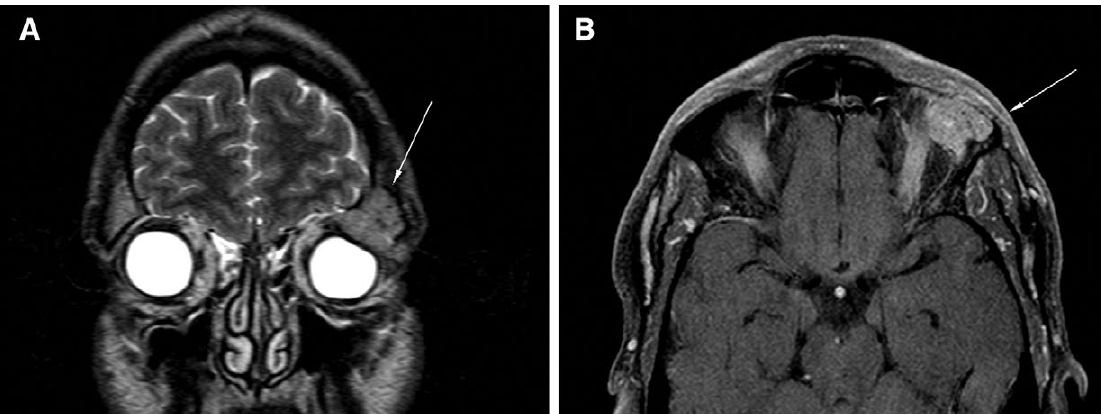
Figure 1. Magnetic resonance imaging: Coronal T2 TSE sequence ( A ) and coronal SE T1 sequence with fat suppression ( B ), showing expansive lesion of probable bone origin with intraorbital devel - opment, which appears isointense in T2 and shows contrast enhancement on T1 fat-suppressed sequence (white arrows).